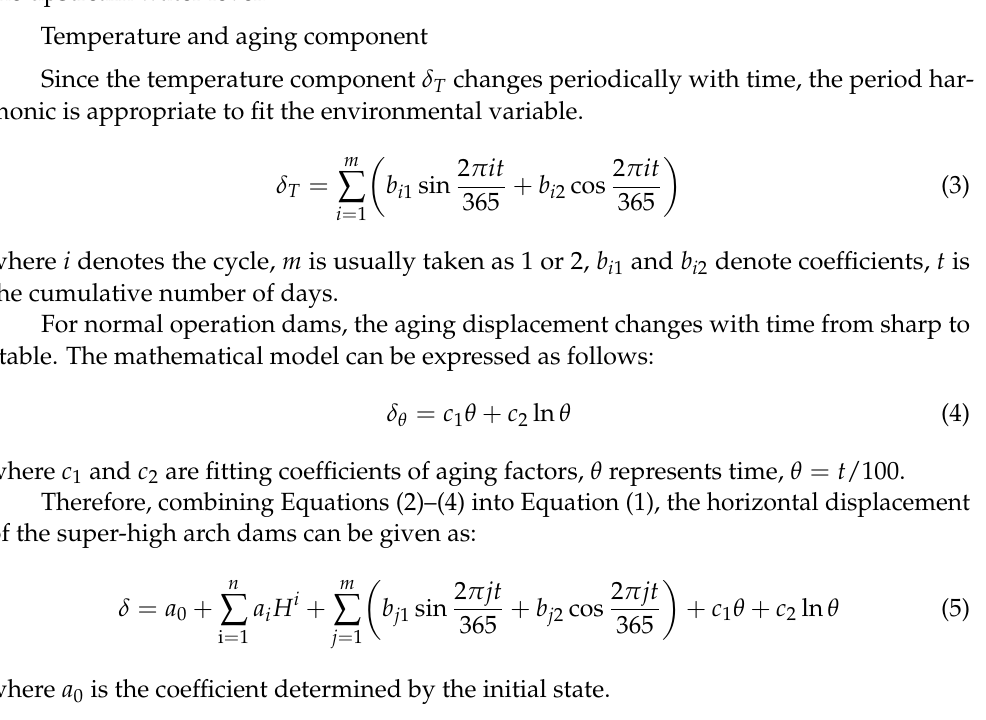
Figure 1. Schematic diagram of water components Through the theory proposed by Wu, δ 1 H is linearly related to H , H 2 and H 3 , and δ 2 H is linearly related to H 2 and H 3 , δ 3 H is linearly related to H . Since the research object of this paper is arch dam, we add the explanatory variables of arch dam. Therefore, the expression of the component